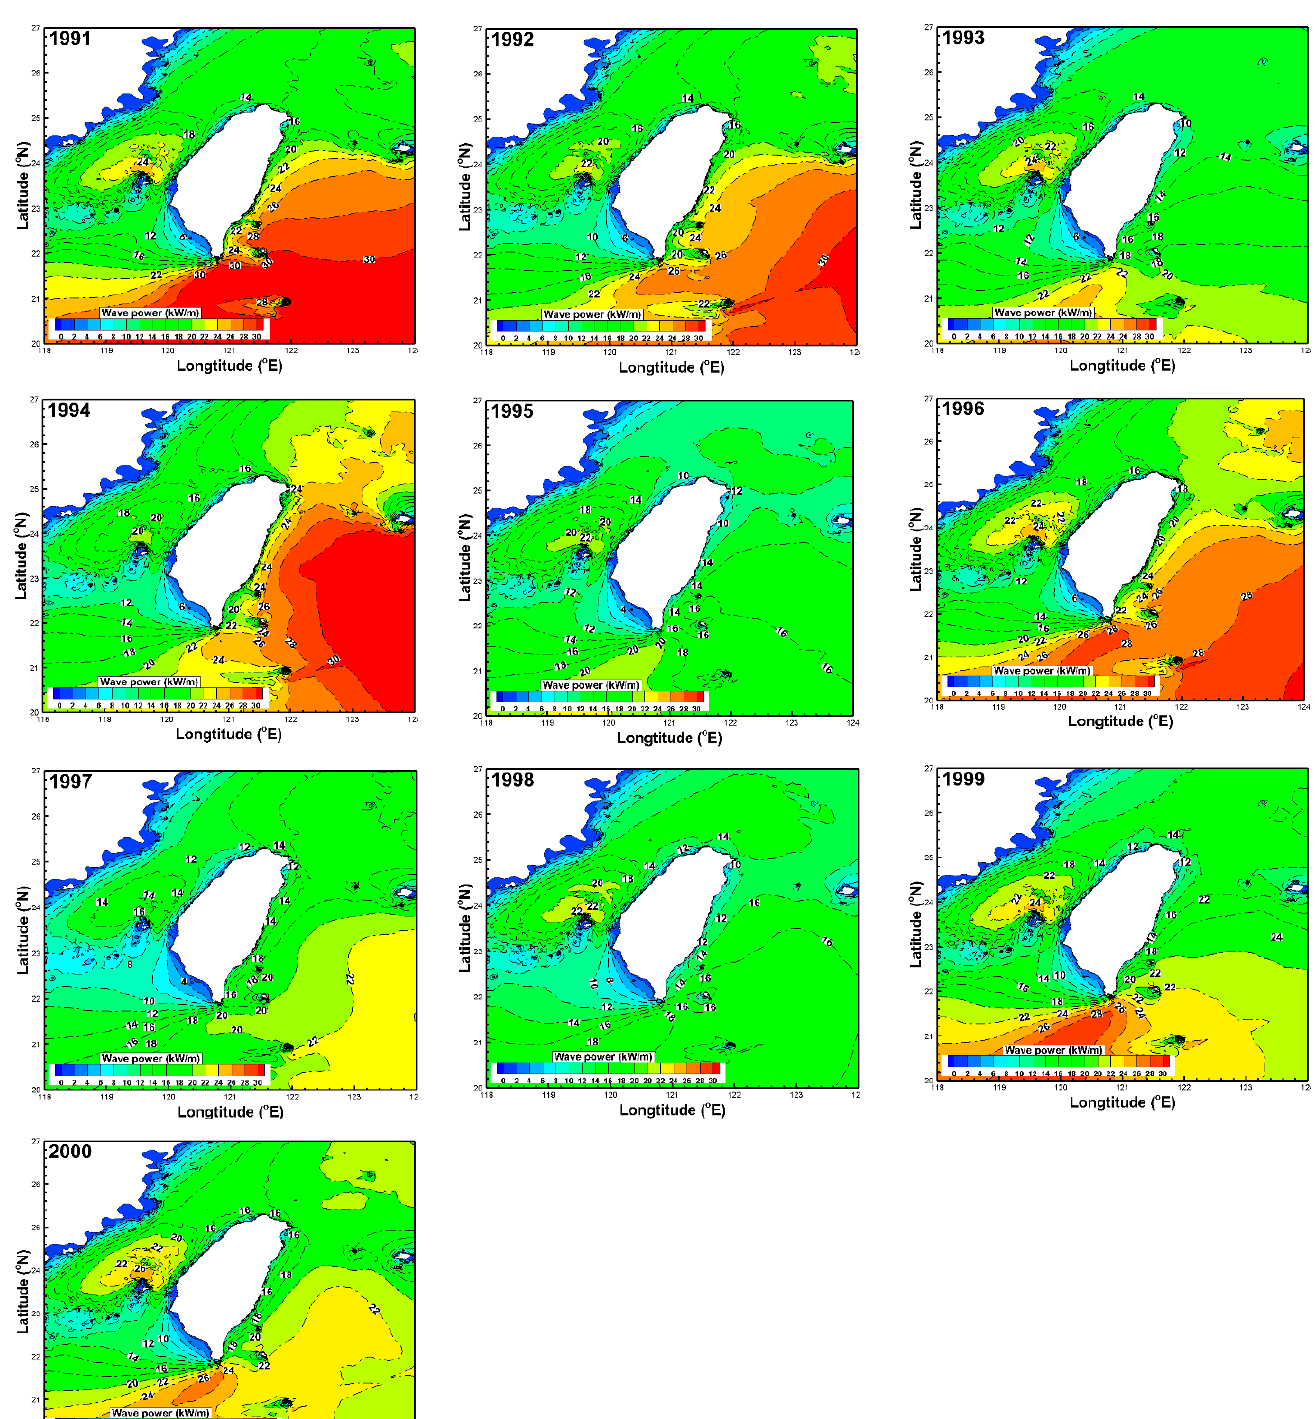
Figure 7. Spatial distributions of the annual average wave power in the offshore waters of Taiwan from 1991 to 2000.